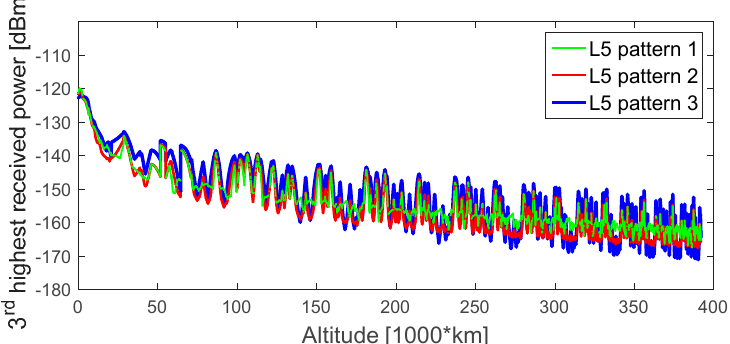
Figure 21. Third-highest received power level of GPS L5 signals, during the considered MTO, for a 0 dBi receiver gain pattern.